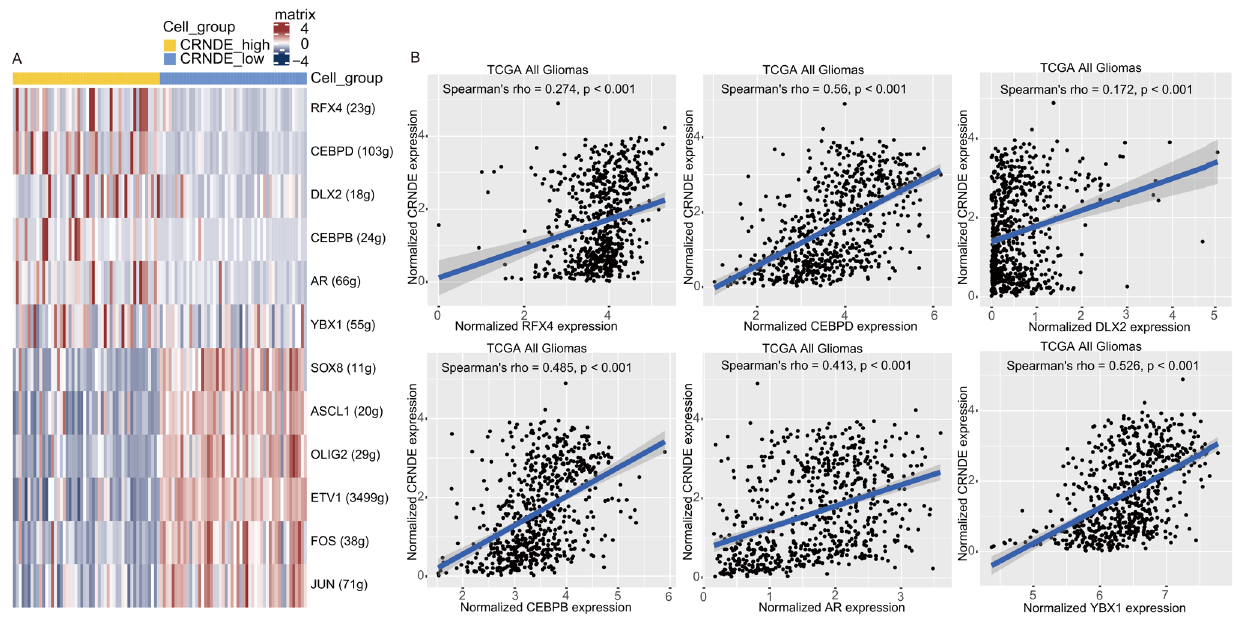
Figure 9. Transcriptional regulation of CRNDE in glioma. ( A ) Heatmap of TF activity by SCENIC in scRNA-seq data. ( B ) Correlations between the expression of CRNDE and RFX4, CEBPD, DLX2, CEBPB, AR, or YBX1 verified by Spearman’s correlation analysis in TCGA.